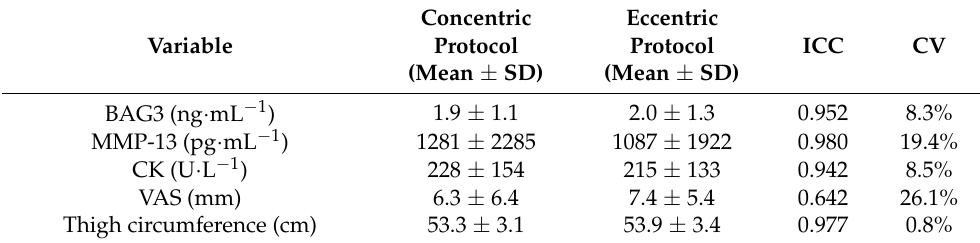
Table 3. Baseline values of markers of muscle damage assessed prior to each loading.